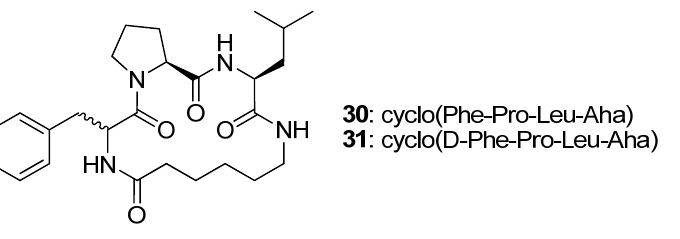
Figure 8. In 30 the Phe-Pro element adopts a type VIa2 β -turn conformation, whereas